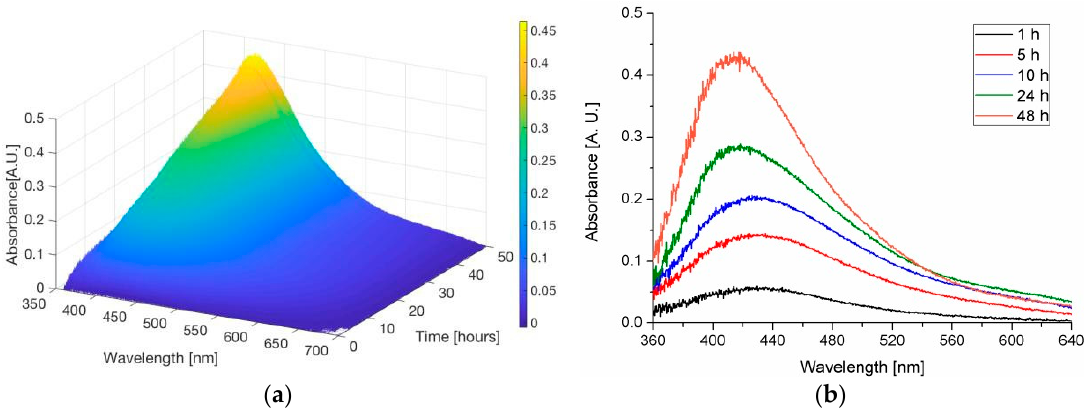
Figure 2. ( a ) 3D plot of the development of the plasmonic absorbance peak of a PDMS-Ag nanocomposite film. ( b ) Absorbance spectra of the same composite film after given time periods. A baseline drift correction was applied at the data, based on the drift measured at 700 nm.